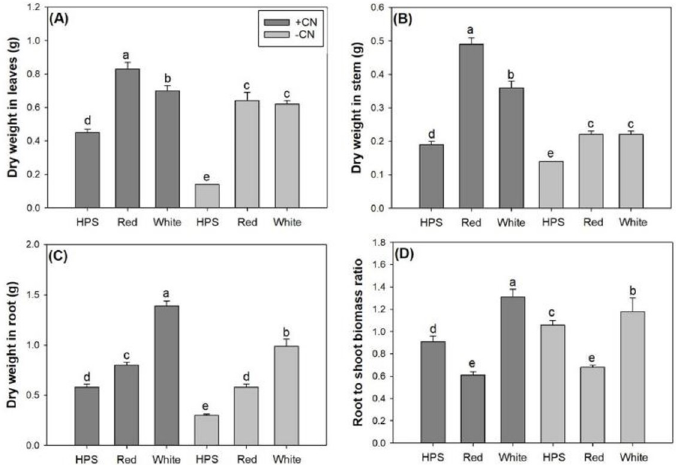
Fig 4. Dry weight in leaves (A), stem (B) and root (C) and root to shoot biomass ratio (D) in Eleutherococcus senticosus seedlings subjected to combined spectra and chitosan nanoparticle addition (CN) treatments. + CN, with CN addition; -CN, without CN addition; HPS, high-pressure sodium spectrum; Red, red-light light-emitting diode (LED) spectrum; White, white-light LED spectrum. Error bars present standard errors and different letters are given over means with differences identified by Turkey test ( α < 0.05). (Table 2) in inducing greater fresh mass weight in seedlings exposed to the red-light spectrum (2.62 ± 0.37 g) and white-light spectrum (4.11 ± 0.29 g) relative to those exposed to the HPS spectrum (1.65 ± 0.31 g) (Fig 5C). The CN addition also resulted in greater fresh mass weight in roots (3.11 ± 0.86 g and 2.47 ± 0.90 g for CN and control, respectively).